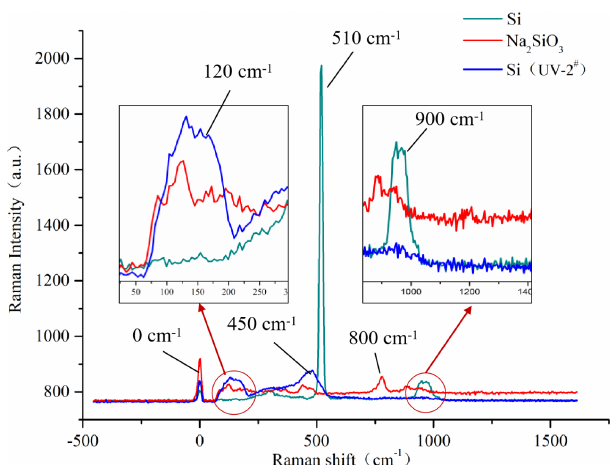
Figure 3. The Raman spectroscopy analysis of the Si and Si (UV- 2 # )